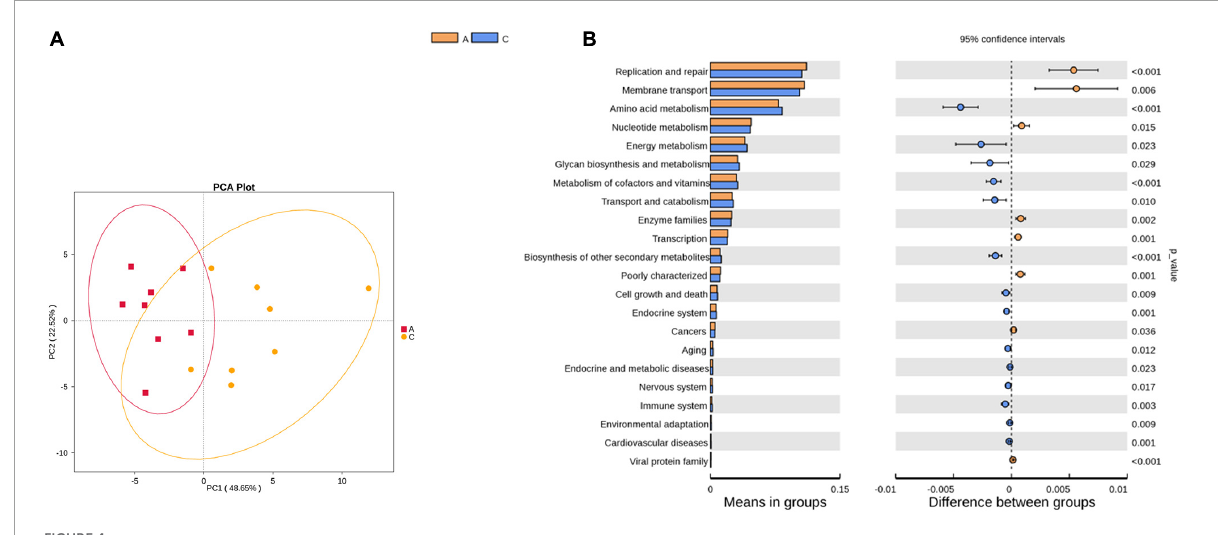
FIGURE4 Principal component analysis (PCA) plot of microbial community function prediction at level 2 in APP/PS1 and wild-type mice (A) and comparative plots of significantly different pathways (B) . Groups: A, APP/PS1 double-transgenic mice; C, wild-type control group of C57BL/6J mice; n =